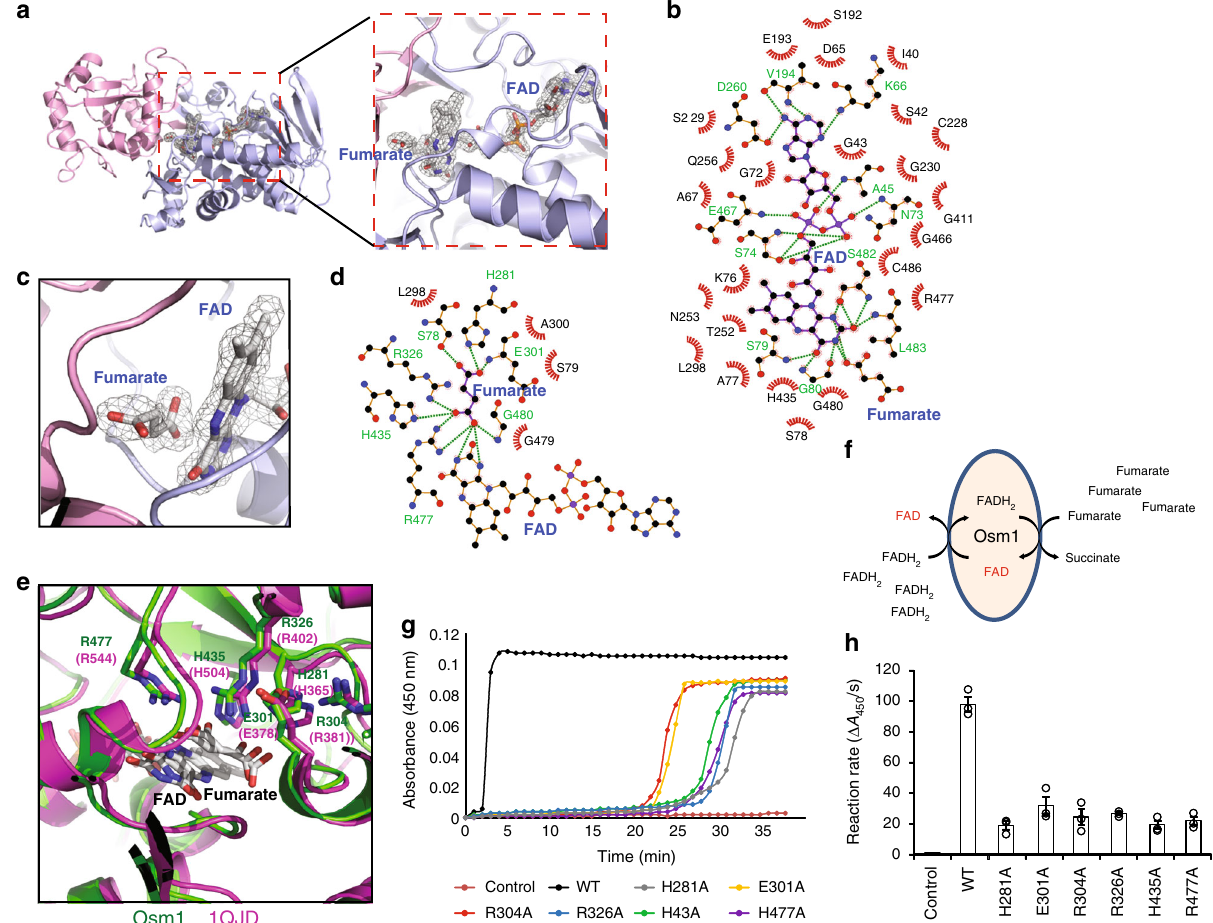
Fig. 2 Structural analysis of the catalytic site in Osm1. a An omit density map contoured at the 1 − σ level around the active site. The fl avin and clamp domains are shown in blue and pink, respectively. The active site is shown by the red dotted rectangle. The FAD and substrate-binding site is magni fi ed for better visualization. b A 2D FAD-Osm1 interaction diagram. The residues involved in the FAD interaction are indicated. Green-colored residues are involved in hydrogen bonding. The green dotted lines indicate hydrogen bonds. The 2D interaction diagram was generated by Ligplot 30 . c The substrate-binding site, magni fi ed to show a clear electron density map. d The 2D substrate (fumarate)-Osm1 interaction diagram. The residues involved in the substrate accommodation are indicated. e Structural comparison of the active site of Osm1 with Fcc3 fumarate reductase from Shewanella frigidimarina (1QJD). The location of six completely conserved amino acids which may be critical for Osm1 activity, H281 (H365), E301 (E378), R304 (R381), R326 (R402), H435 (H504), and R477 (R544), are indicated. f Electrons can be transferred from FADH 2 to fumarate in the absence of oxygen. The fumarate reductase activity of Osm1 can be assessed by monitoring the oxidation of free FADH 2 based on the absorbance of FAD at 450 nm. g Comparison of fumarate reductase activities of Osm1 wild type and its catalytic mutants. Oxidation of FADH 2 was monitored under anaerobic environment induced by sodium dithionite. A representative reaction curve among three replications was provided. h Bar graph of fumarate reductase activity of Osm1 wild type and its mutants. The corresponding dot plots were overlaid in the bar charts. The reaction rates were calculated based on reaction curves ( n = 3, error bar was derived bystandard